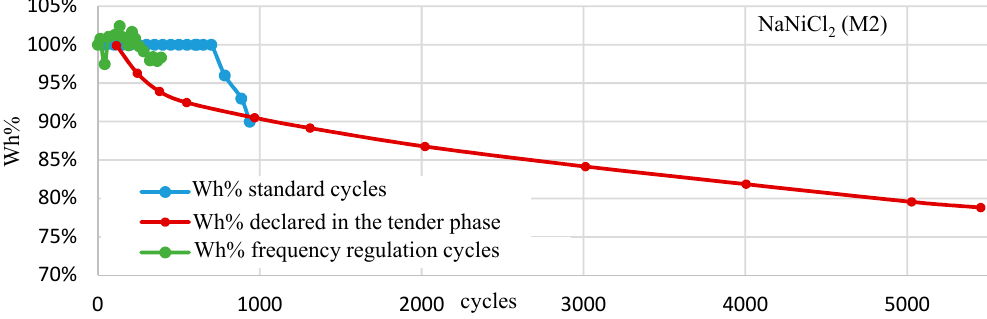
Figure 12. NaNiCl2 (M2) technology: comparison between the expected ageing, declared in the tender phase, and the ageing after the standard and frequency regulation cycles.